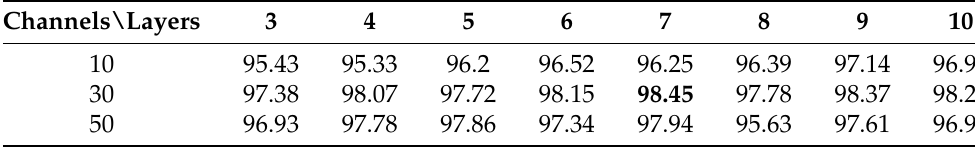
Table 10. RRAM accuracy estimation